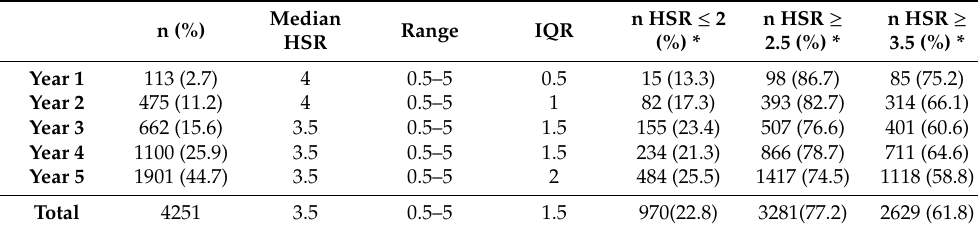
Table 1. Descriptive statistics for total sample by implementation year.